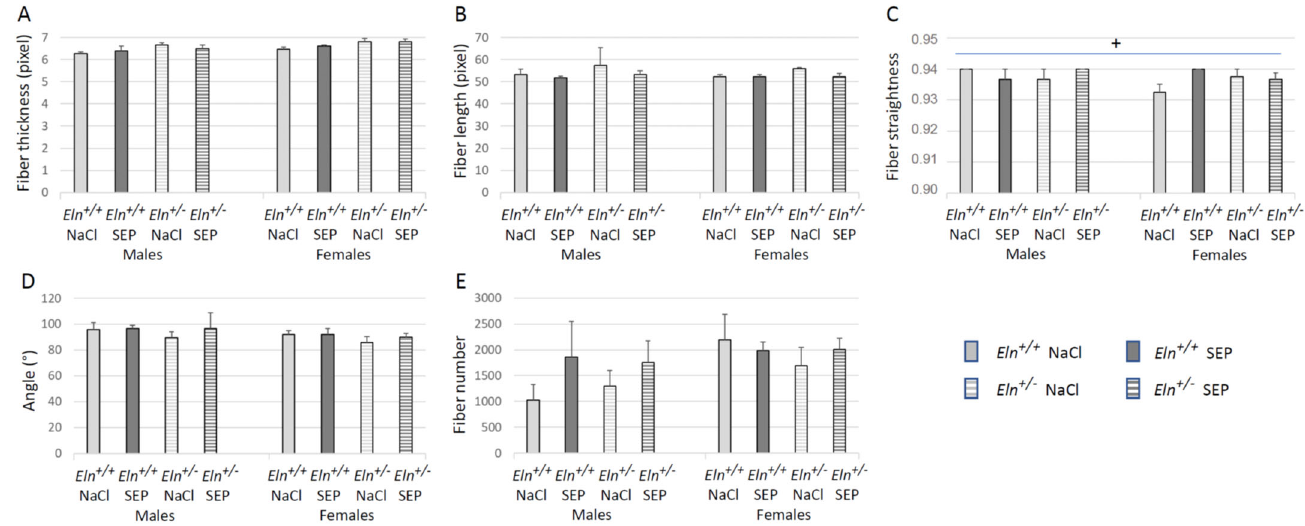
Figure 8. CT-FIRE analysis of picrosirius red-stained cross-sections of the distal part of the aortic arch (entire aorta wall section) illuminated with polarized light. The measurements were performed 3 days after NaCl (control) or SEP intravenous injection in the caudal vein of male and female mice of Eln +/+ or Eln +/- genotypes. Individual properties and quantity of collagen fibers were compared between the studied groups: ( A ) fiber thickness, ( B ) length, ( C ) straightness, ( D ) angle and ( E ) number of fibers per aorta. + significant interaction between sex, genotype and SEP treatment (three-way ANOVA, p ≤ 0.05), showing that the elevation of collagen fiber straightness in untreated Eln +/+ males, compared to Eln +/+ female mice, was abolished by the SEP-induced increase in collagen fiber straightness in female Eln +/+ mice (post hoc Fisher’s least significant difference (LSD) tests, p ≤ 0.05). Control animals were injected with the same volume of 0.9% NaCl (NaCl). Values are mean ± SEM. n = 3–6 in each group.